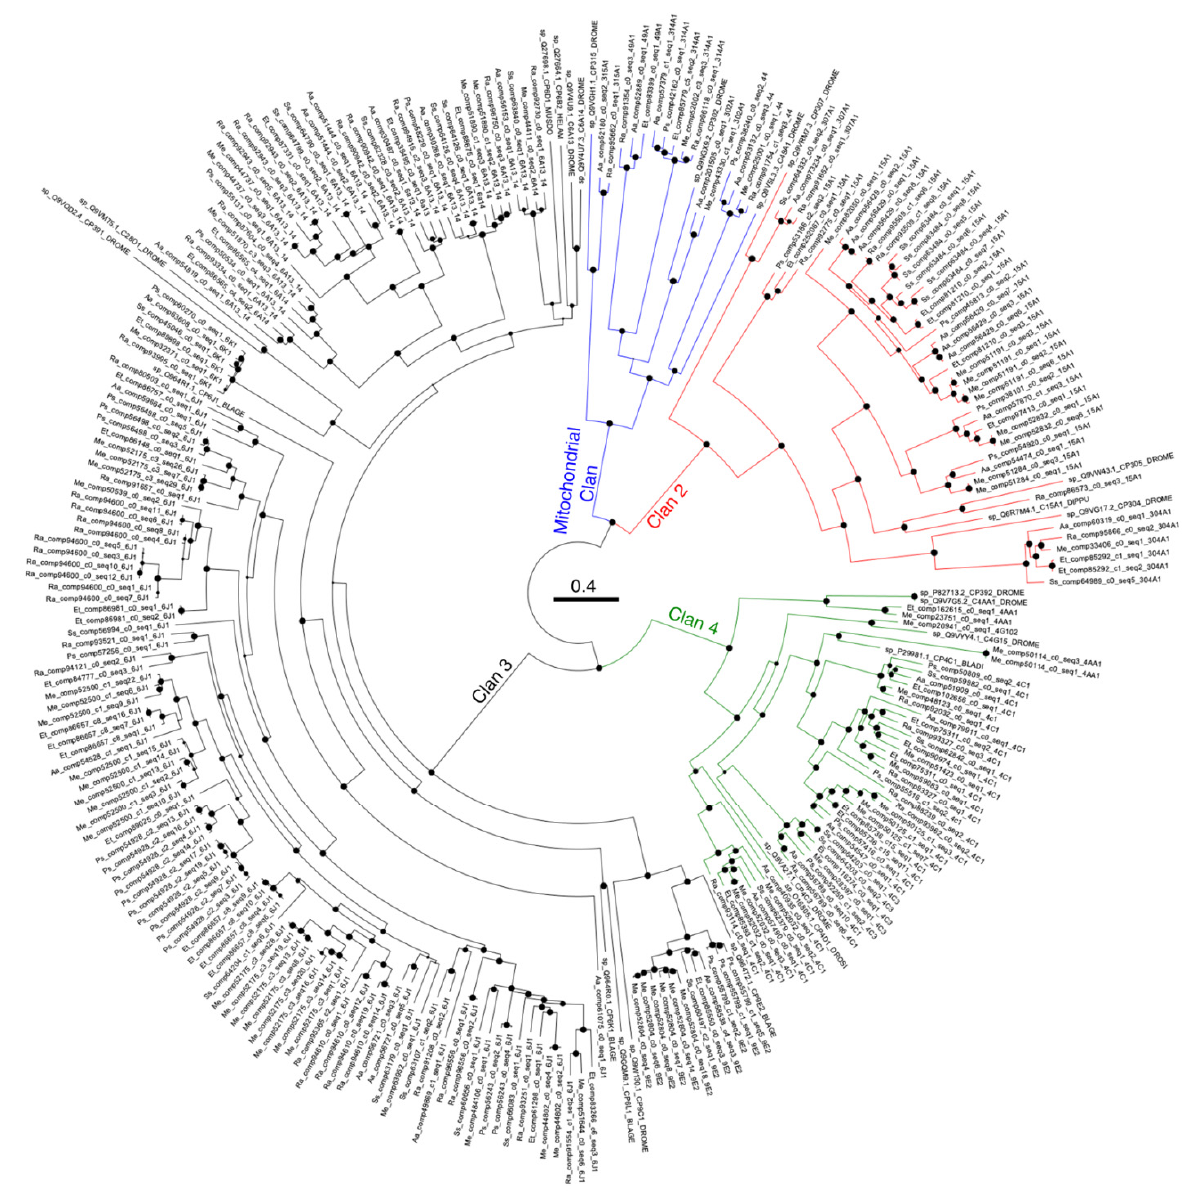
Figure 1. Maximum-likelihood phylogenetic tree of the Phasmatodea CYP450s . The evolutionary history was inferred using the Maximum likelihood method with the model LG+I+G4, identified as the best via Bayesian information criterion scores. The consensus tree with the log-likelihood − 129,334.593 is shown, with the sum of branch lengths 72.0129. The percentage of replicate trees in which the associated taxa clustered together in the bootstrap test (1000 replicates) are depicted as ten possible sizes of circles at the nodes, with the largest nodes indicating 100% [41]. The tree is drawn to scale, with branch lengths in the same units as those of the evolutionary distances used to infer the phylogenetic tree. The tree was edited using FigTree v 1.4.4 and Adobe Photoshop. Phasmatodea